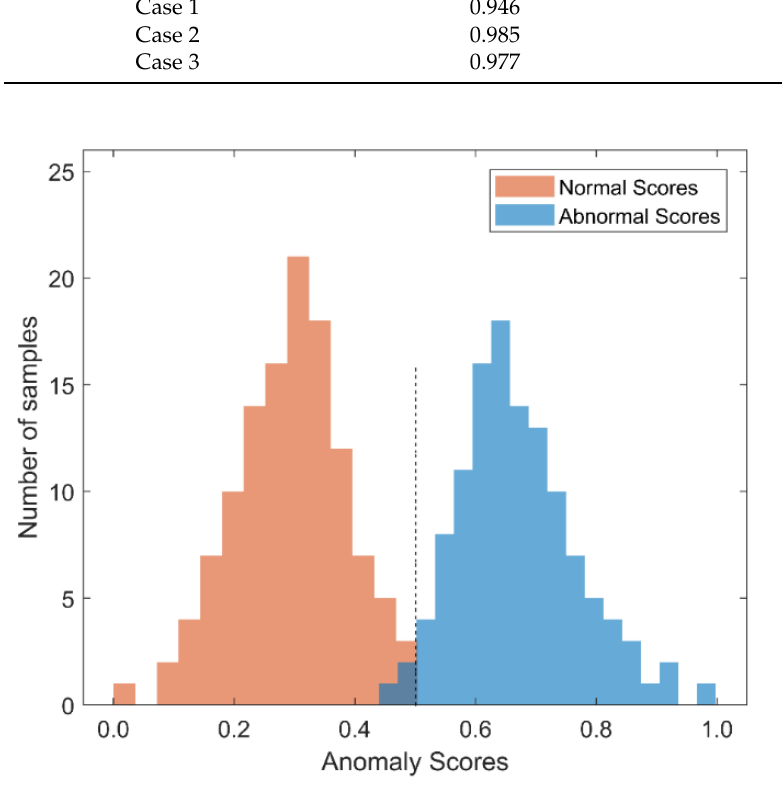
Figure 11. Histograms of normal and abnormal scores for samples of current data tested with our method. Table 5. Experimental results of our method under three input conditions. Table 6. Evaluation results of our method under three input conditions (the threshold is set to